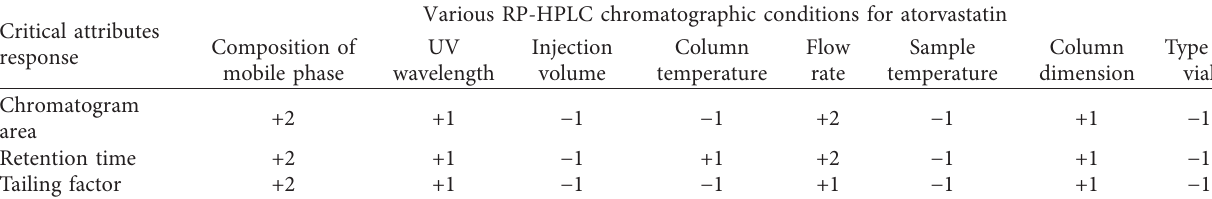
Table 1: RP-HPLC analytical method risk assessment for